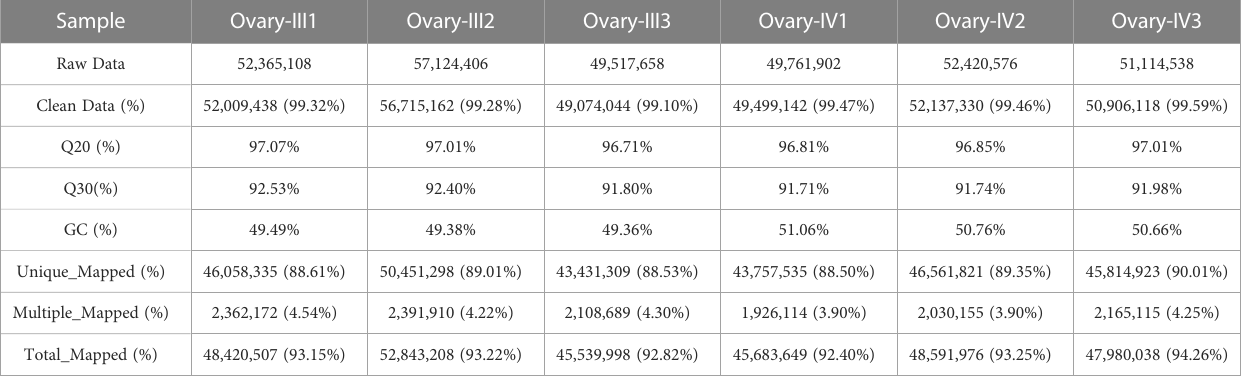
TABLE 1 Categorization of mRNA reads in the different